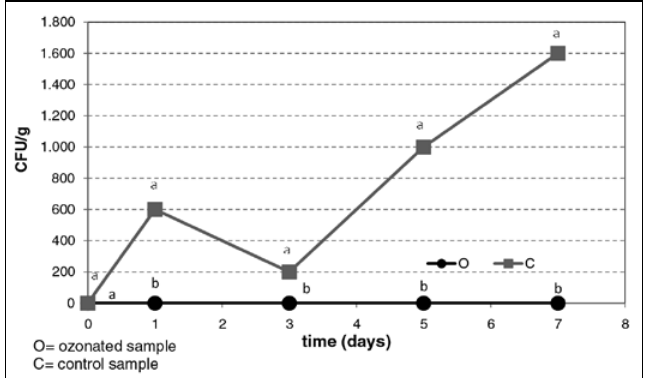
Fig. 2 - Evolution of total coliforms during storage at 4°C. For each storage time, data followed by different letters are significantly different (t- Student test at p<0.05). (Ölmez and Kretzschma, 2009).